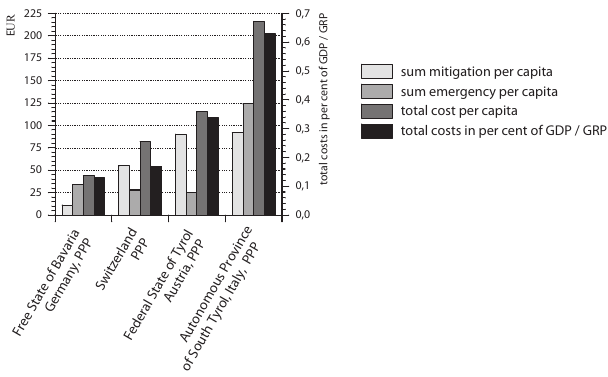
Fig. 3. Per capita expenditure for mitigation, emergency (in EUR PPP values, reference years: 2007–2010) and total costs in per cent of gross domestic/regional